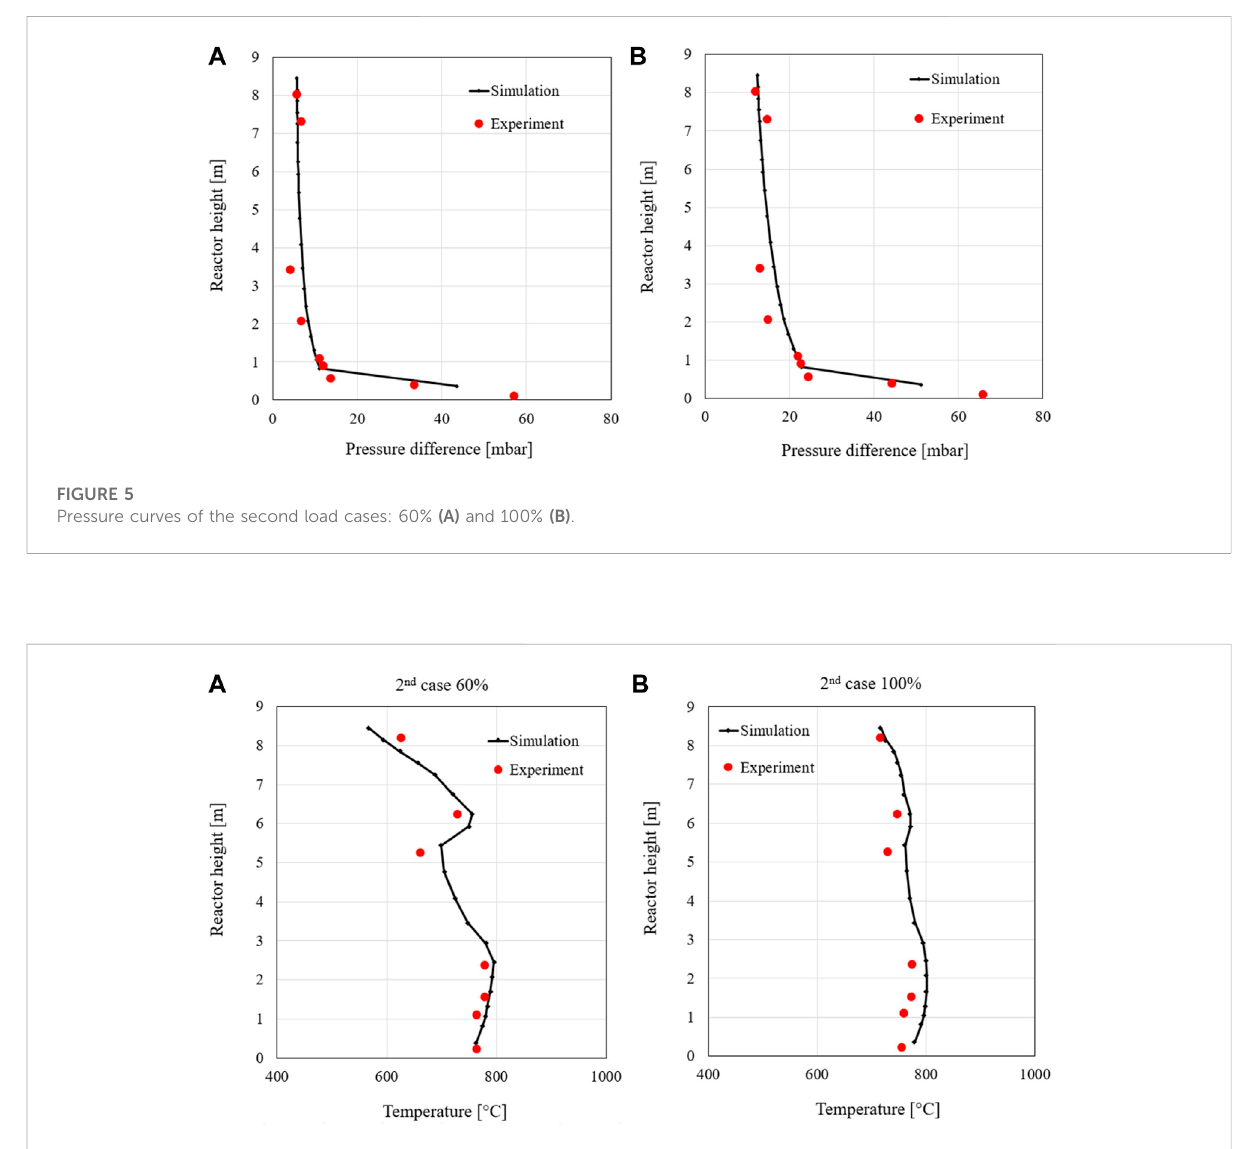
FIGURE 6 Temperature pro fi les of the second 60% (A) and 100% (B) load